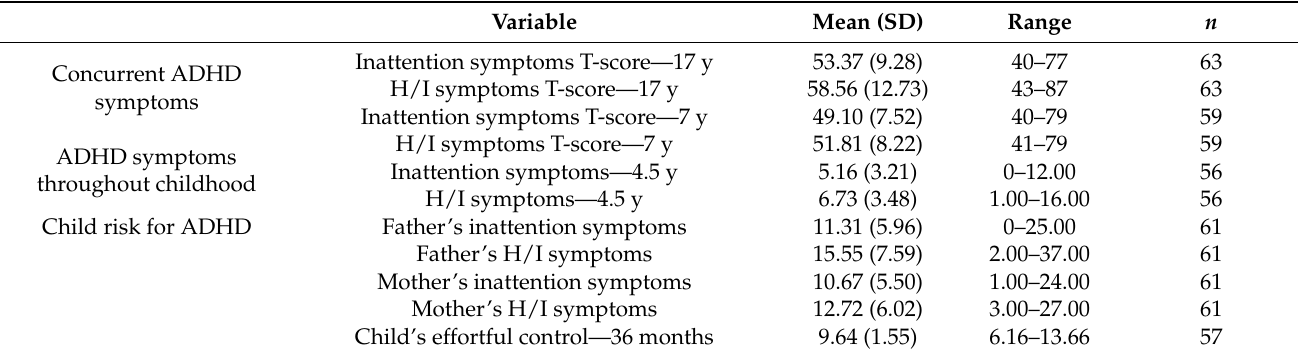
Table 2. Descriptive Statistics of ADHD Symptoms throughout Development and Child Risk for